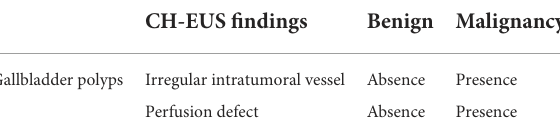
TABLE 3 Characteristic findings of gallbladder polyps in